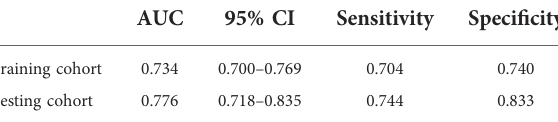
TABLE 5 Performance of a constructed nomogram for predicting 1- year survival of gallbladder cancer patients with liver metastasis in the training and testing